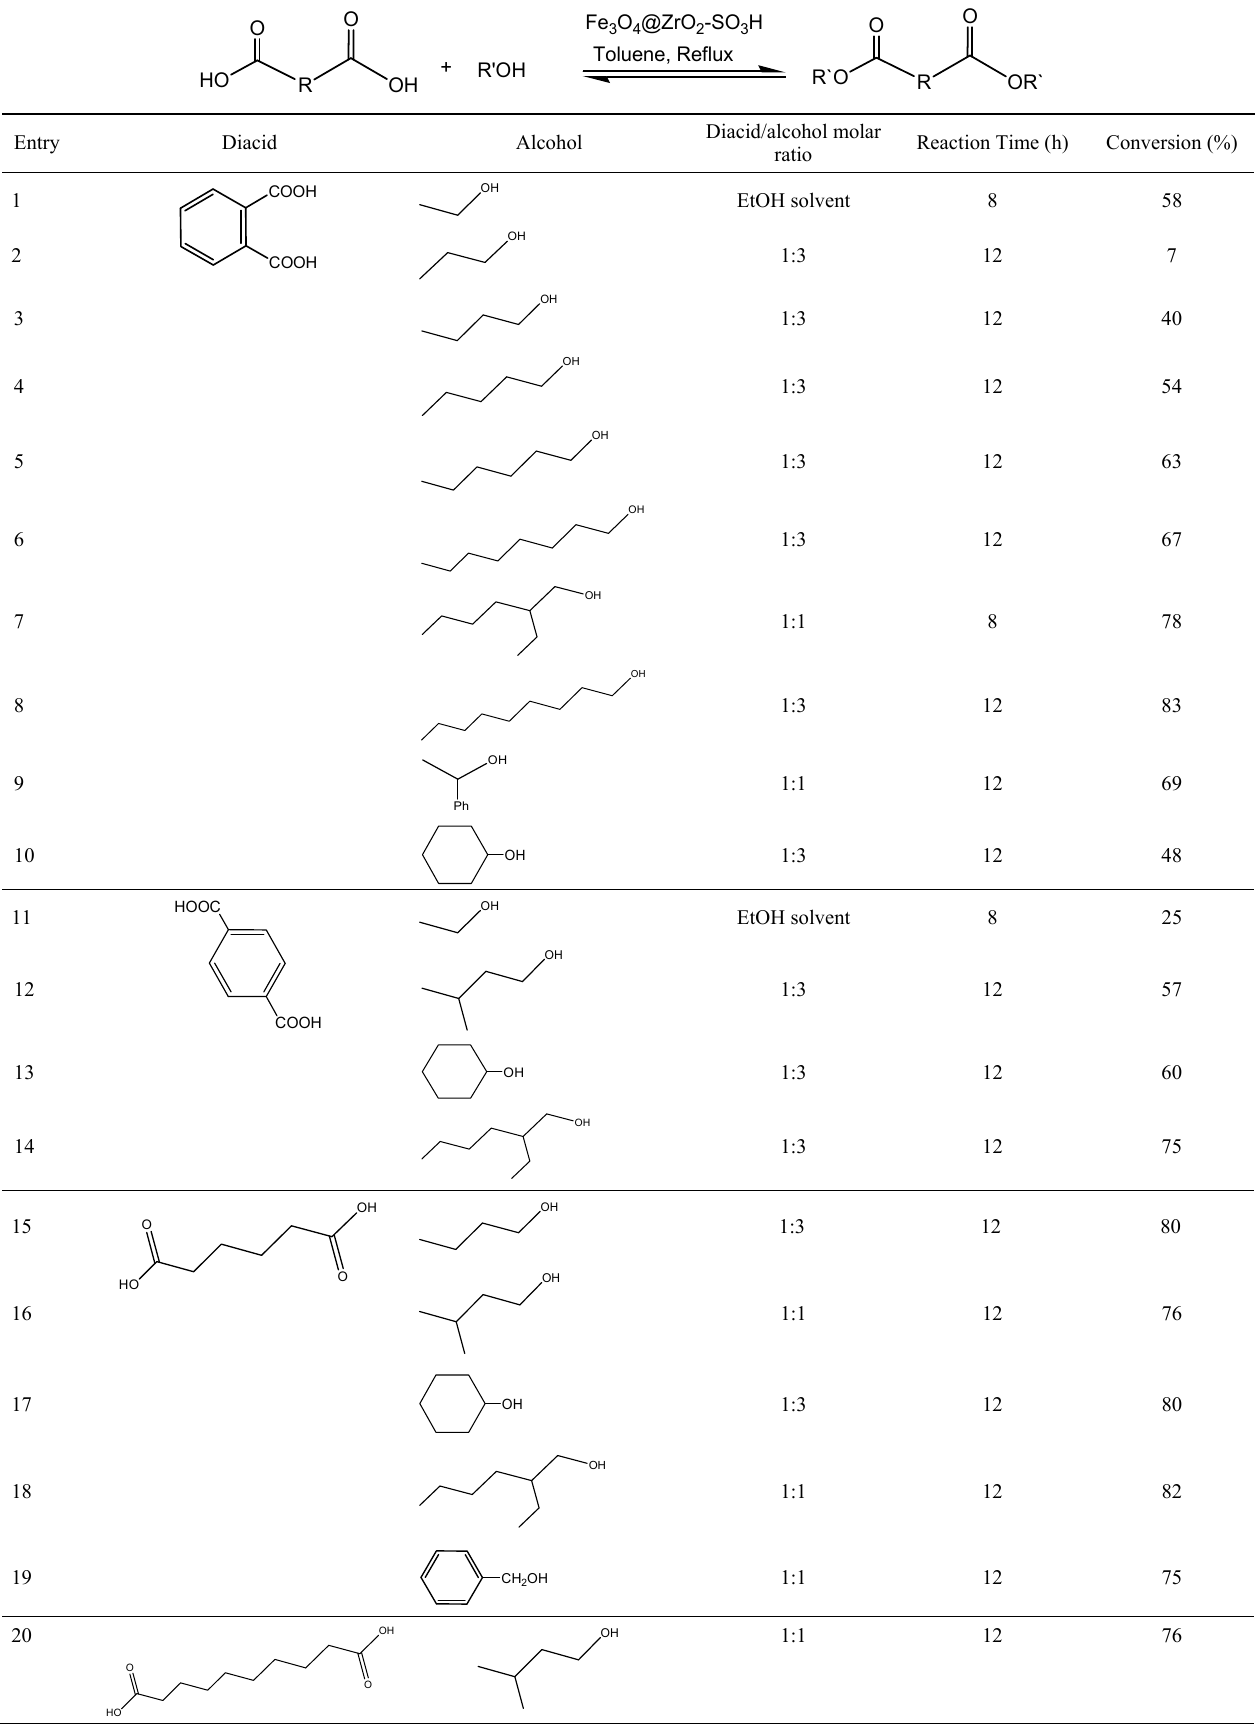
Table 6. Reaction conditions and conversions of dicarboxylic acids by various alcohols. a